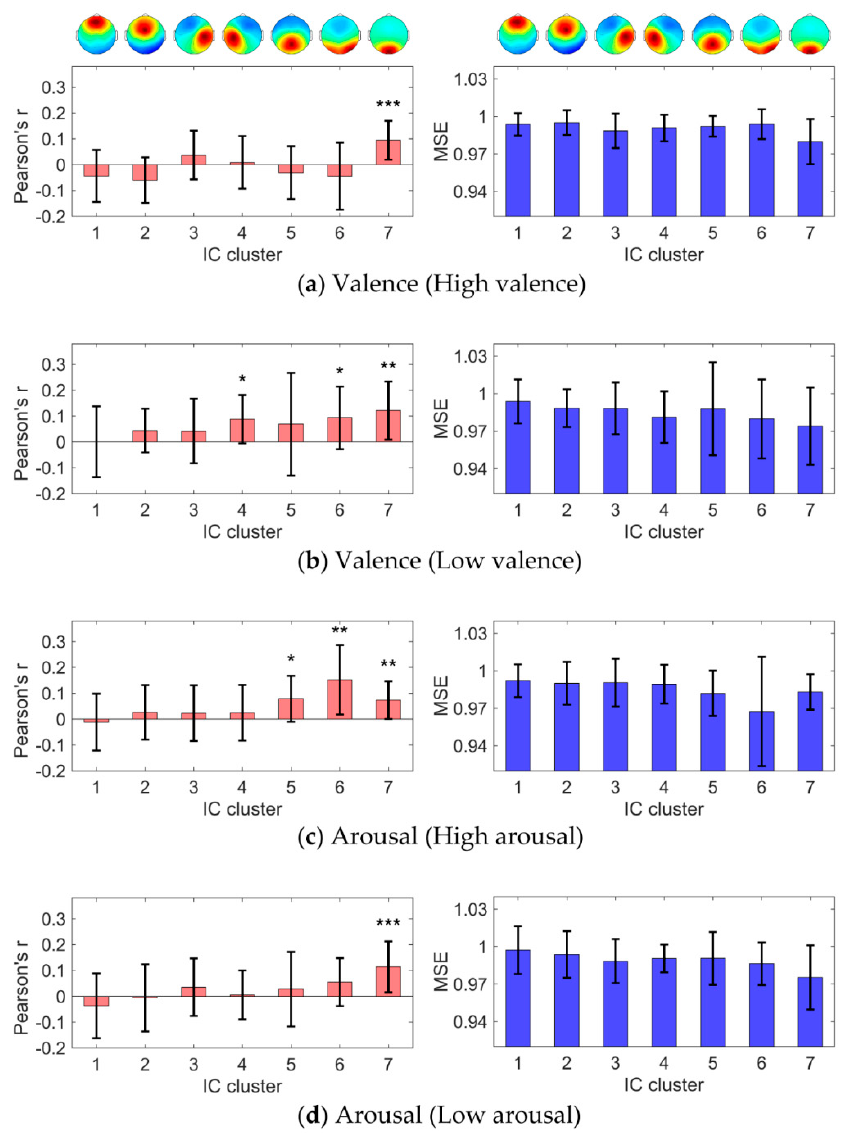
Figure 4. Prediction accuracy of the seven identified IC clusters in the inter-participant regression. Error bars represent standard deviations. ( a ) Regression of the high-valence state. ( b ) Regression of the low-valence state. ( c ) Regression of the high-arousal state. ( d ) Regression of the low-arousal state. (Left column) Pearson’s correlation coefficient between predicted values and International Affective Picture System normative ratings. (Right column) mean squared error (MSE). * p < 0.025, ** p < 0.005, *** p < 0.0005 in one-tailed one-sample t-tests with Holm–Bonferroni correction.